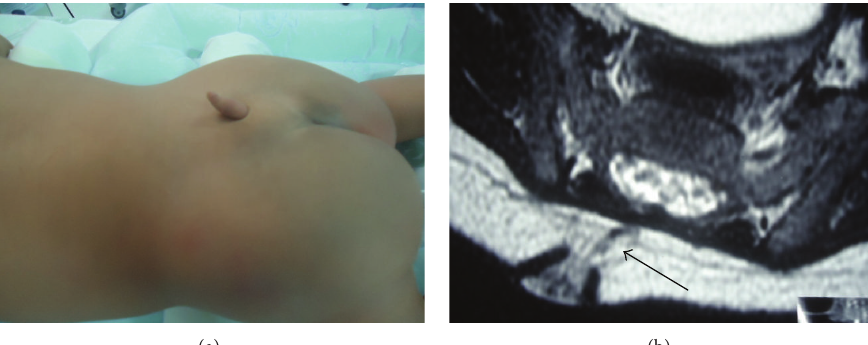
Figure 1: (a) An appendage lesion with approximately 2cm with no communication with the spinal cord. (b) Confirmation by magnetic resonance image (axial image), with development of a false human tail.